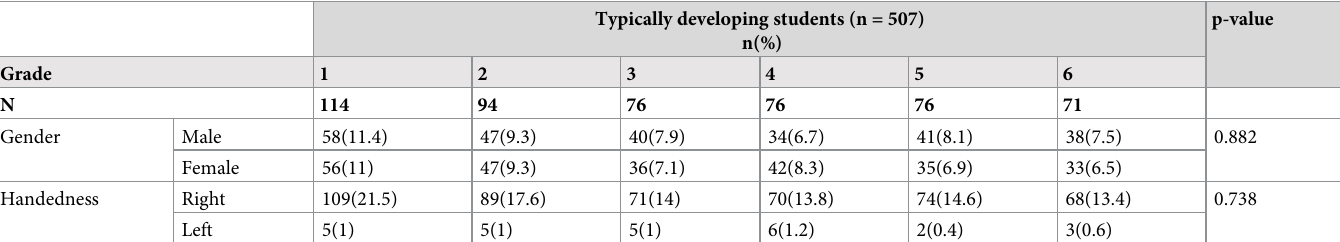
Table 4. Demographic characteristics of typically developing